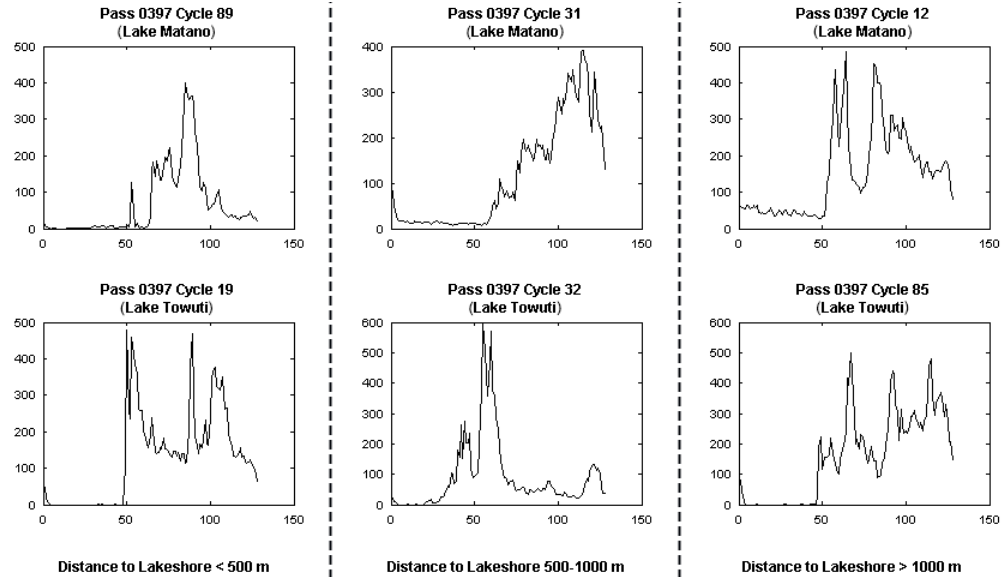
Figure 12. Distinguished waveform shapes as reflected by Lake Matano and Lake Towuti at different buffer distances to the lakeshore.